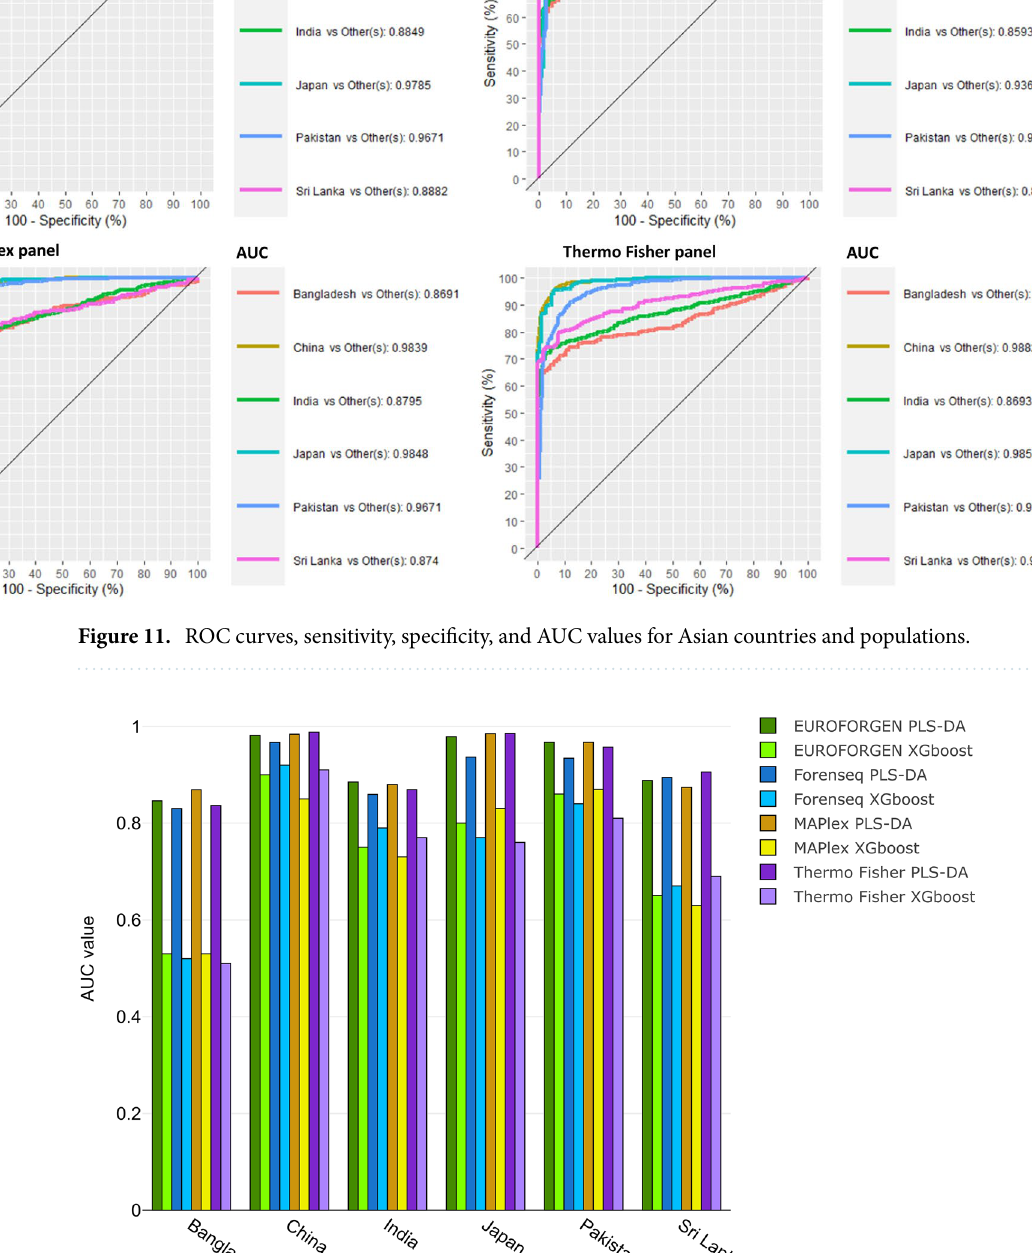
The best AUC values (around 1 for PLS-DA) were obtained when inferring the BGA for individuals from China, Japan, and Puerto Rico, while lower results (around 0.8 for PLS-DA) were obtained when evaluating individuals from Bangladesh, India, and Sri Lanka. The lowest results were showed by the XGBoost model on Bangladesh subjects and, once again, the best performances were achieved with PLS-DA modeling. Finally, no specific AIMs panel or model outperformed the others when evaluating the European countries and populations except for the ForenSeq panel that presents the worst results, presumably due to the low numbers